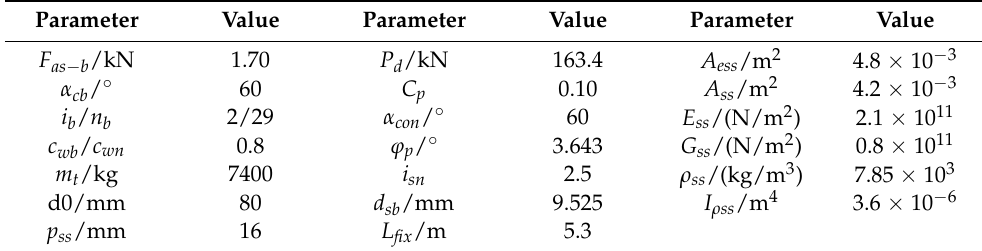
Table 1. The parameters of the experimental